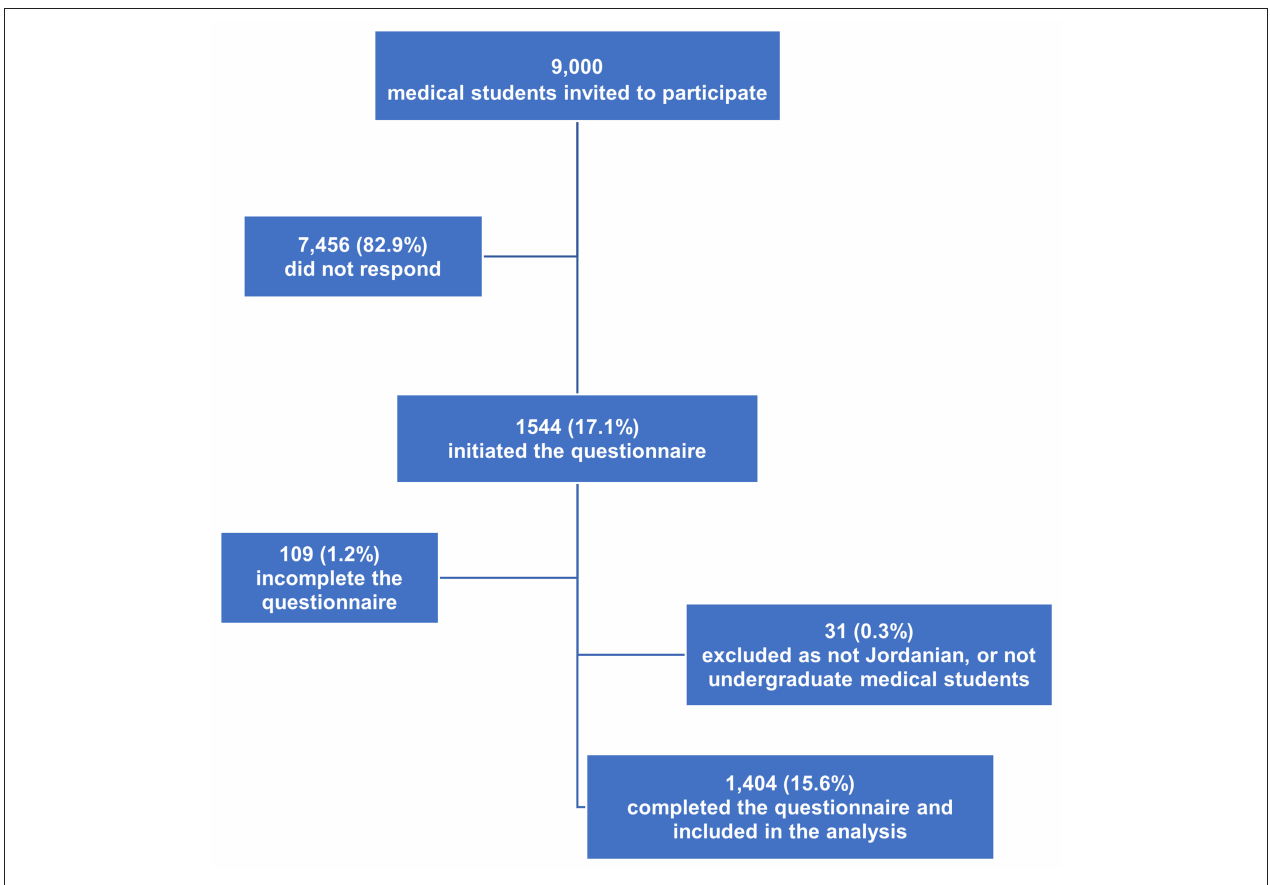
FIGURE 1 | Flow chart of the participants.